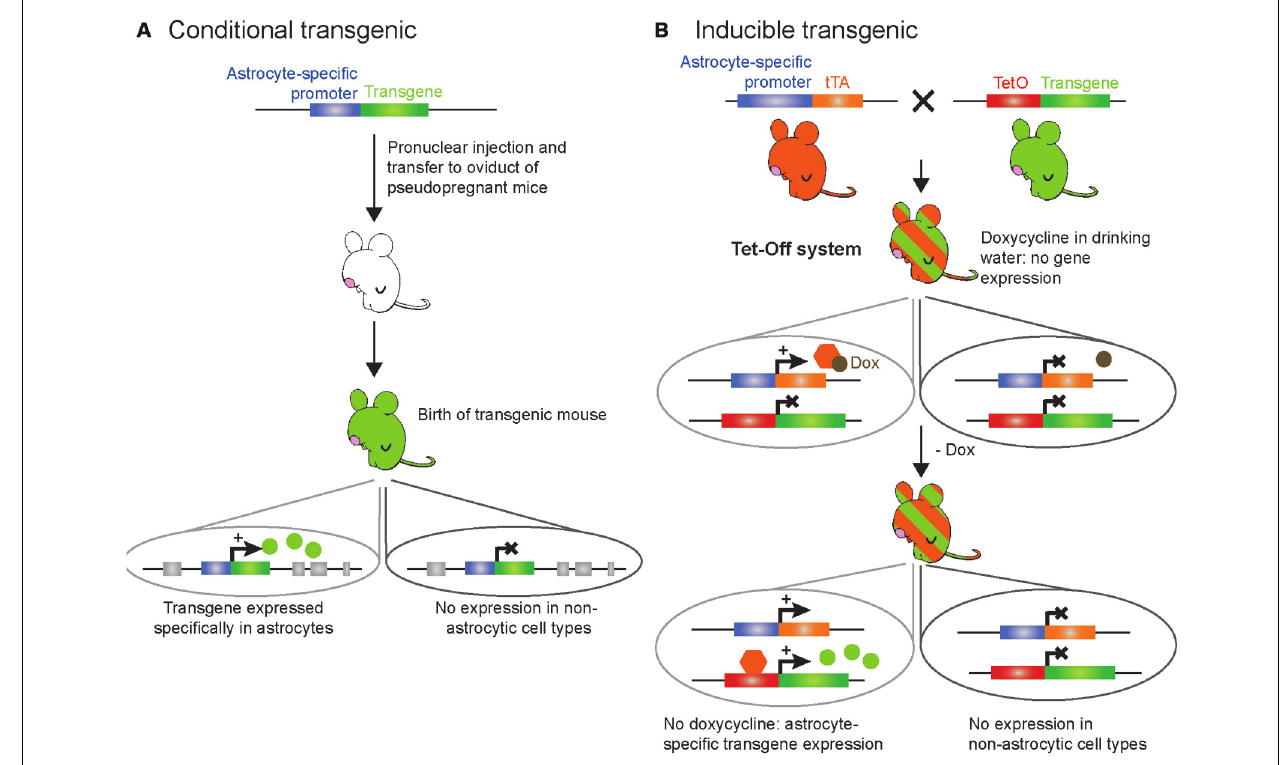
promoter: this line provides astrocyte selectivity to the system.The second transgenic line (green) contains the transgene of interest under the control of the tet operon (TetO) DNA-binding element fused to a minimal promoter from cytomegalovirus.TheTetO promoter element can be activated upon binding of the tetracycline transactivator (tTA) to drive ubiquitous expression.When a tetracycline derivative, such as doxycycline, is given to the bigenic mice (green/orange-striped – obtained from breeding the tTA line with theTetO line) in the drinking water, doxycycline binds to tTA to prevent its interaction with theTetO minimal promoter and thereby turn off transgene expression selectively in astrocytes. Removing doxycycline from the drinking water of the bigenic mice leads to binding of tTA to theTetO minimal promoter and transcription of the transgene of interest within a week.This allows desired temporal expression of the transgene selectively in astrocytes while it is not expressed in other cell types. Additionally, this system allows testing whether potential physiological or behavioral effects of the transgene are reversible by putting the bigenic mice back on